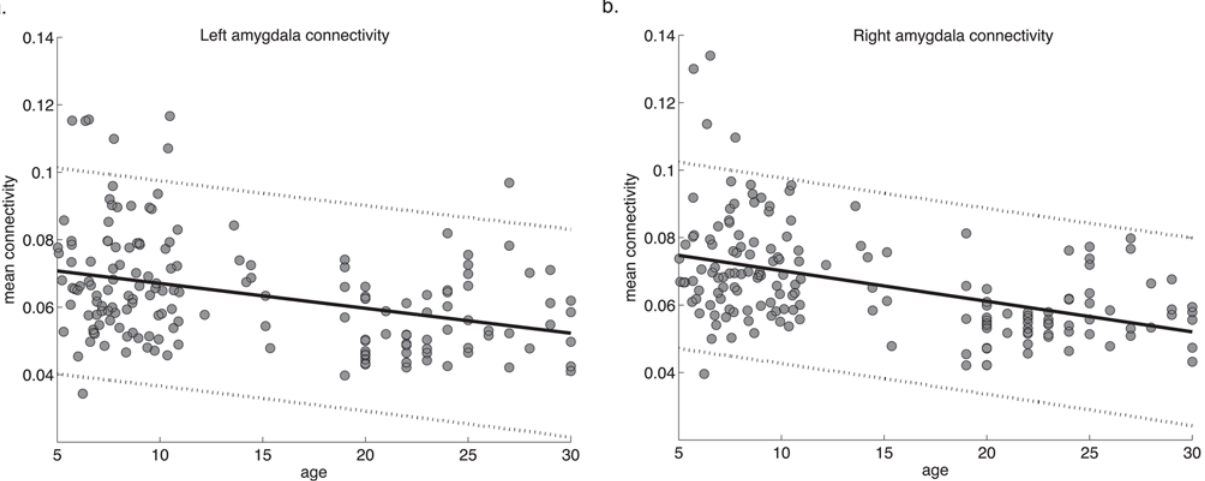
Fig 4. Mean connectivity values with age. Mean connectivity values per participant are plotted by age and were significantly correlated for the a. left and b. right amygdala (left: r = – 0.43, p = 1.41x10 -8 ; right: r = – 0.50, p = 1.59x10 -11 ). Dashed lines indicate 95% confidence